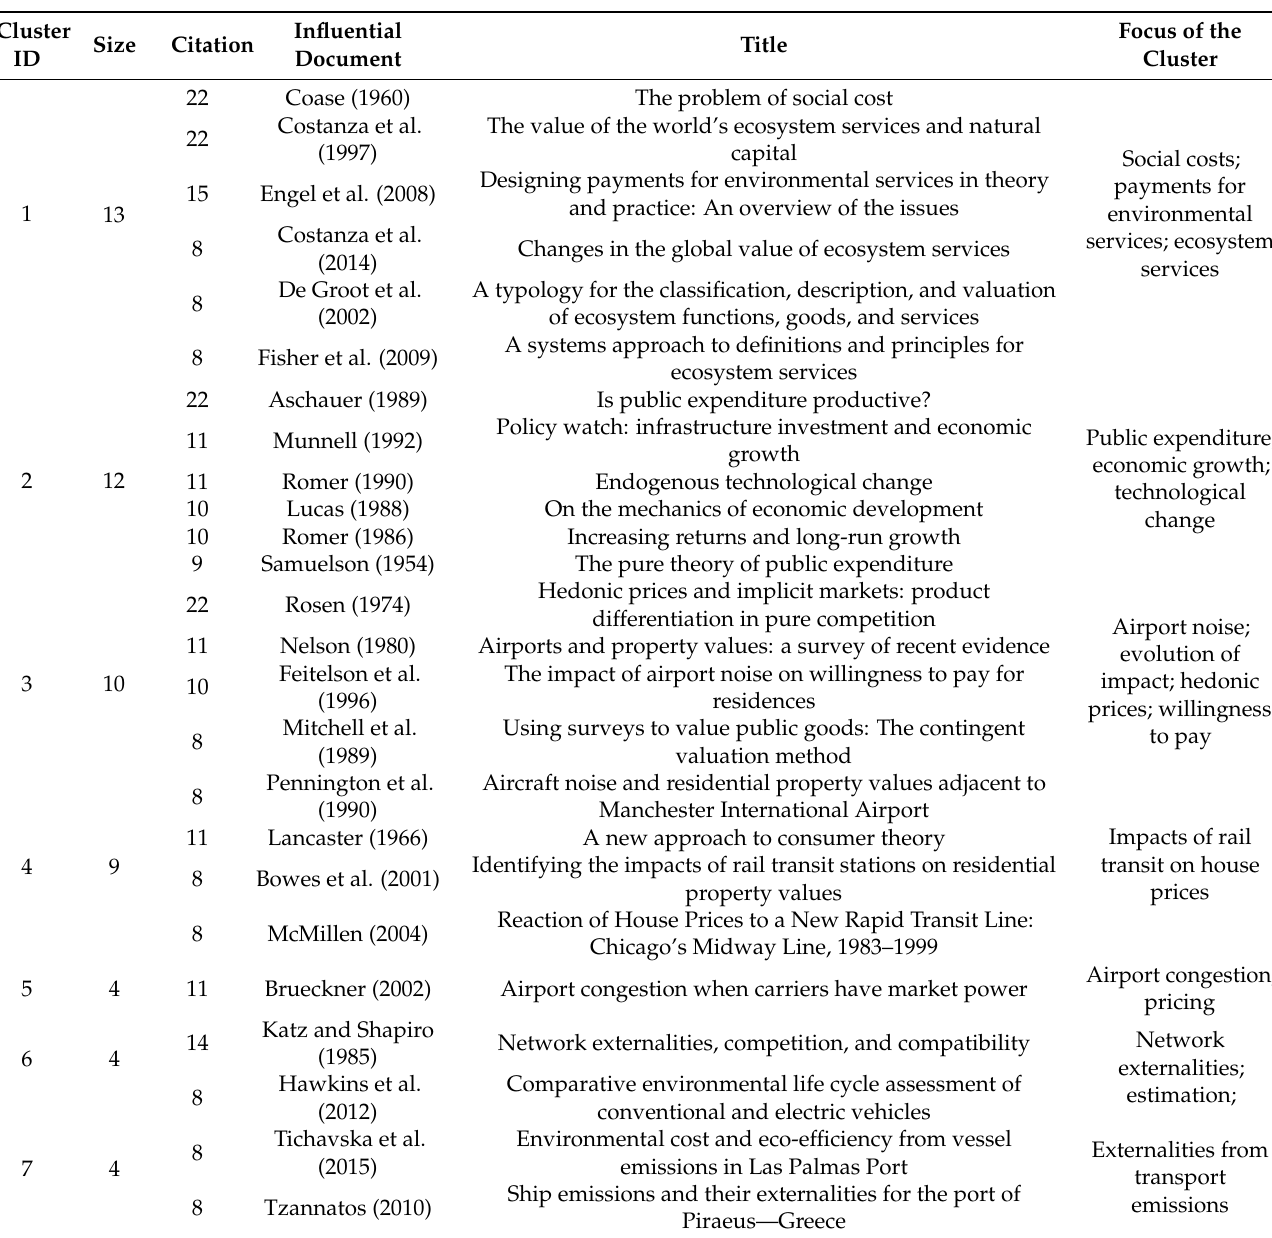
Table 5. Summary of the most influential documents in infrastructure externalities